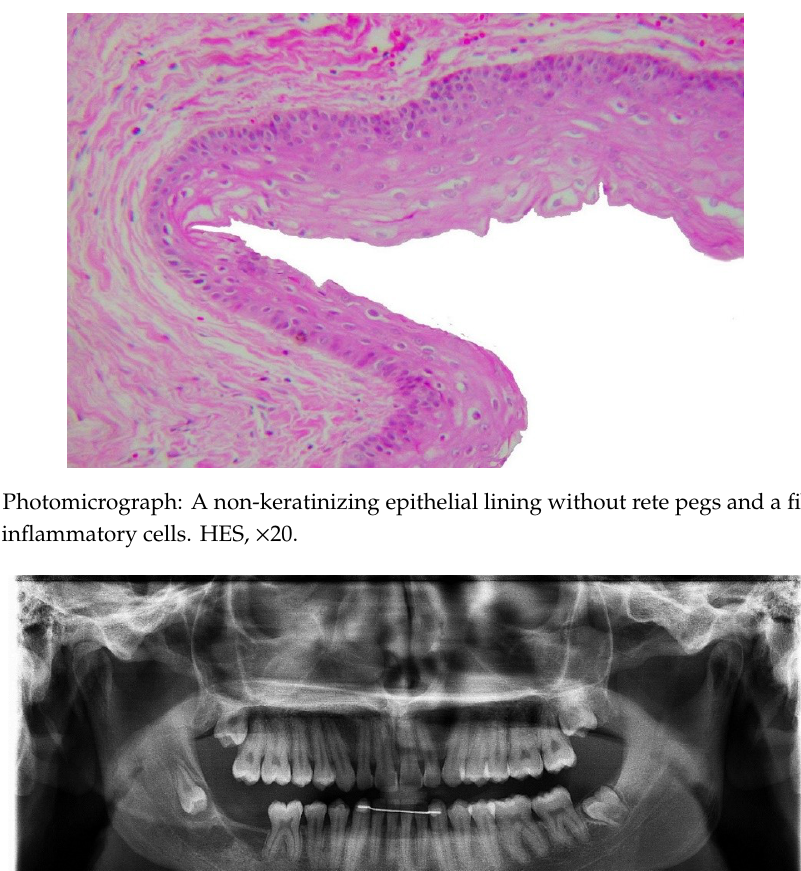
Figure 3. Sagital multi-slice computed tomography (MSCT) image: A large uniloculated lesion involving impacted mandibular right second molar. The lesion attenuation coefficient varies from 3.9 to 22.9 HU.